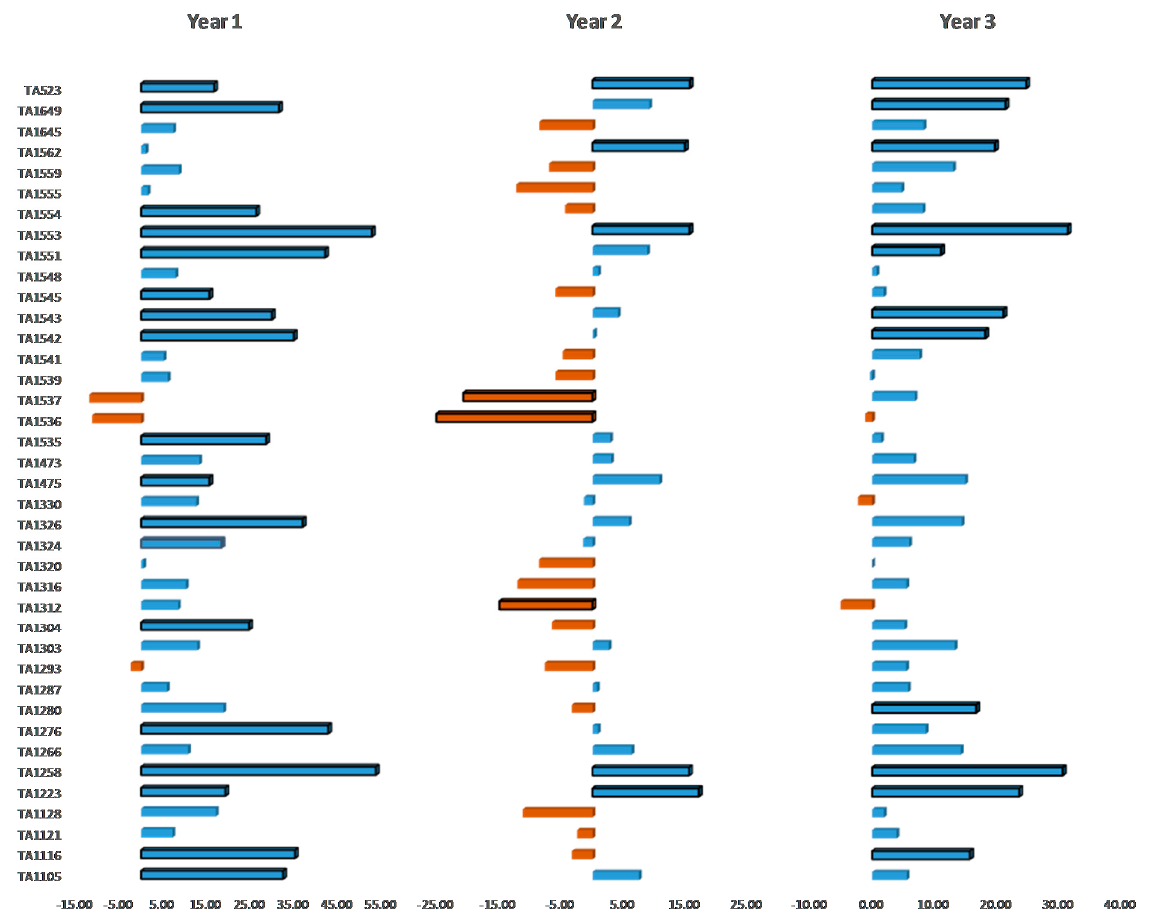
Figure 1. Phenotypic differences (in percentage with respect to the SL recurrent parent as the control) for the soluble solids content in 39 Solanum habrochaites introgression lines tested in three growing seasons. Blue and orange-colored bars with black edges indicate the positive and negative significant differences at p < 0.05, respectively.